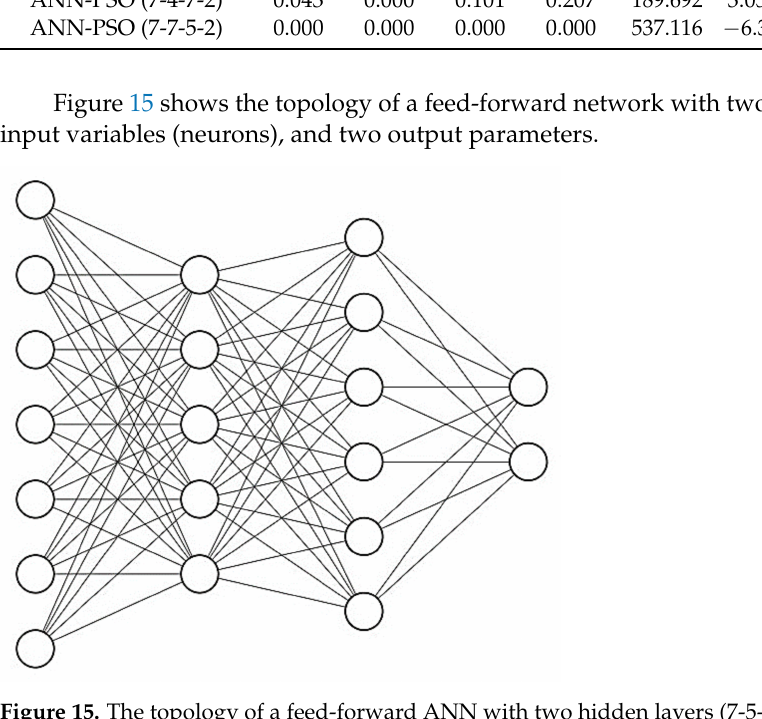
Figure 15. The topology of a feed-forward ANN with two hidden layers (7-5-6-2